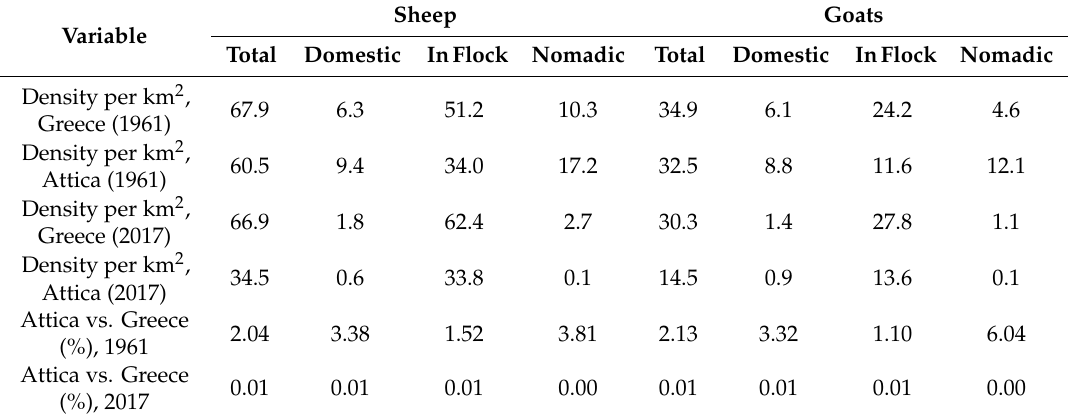
Table 3. Density of sheep and goats (1961 and 2017) by grazing type in Attica and the whole of